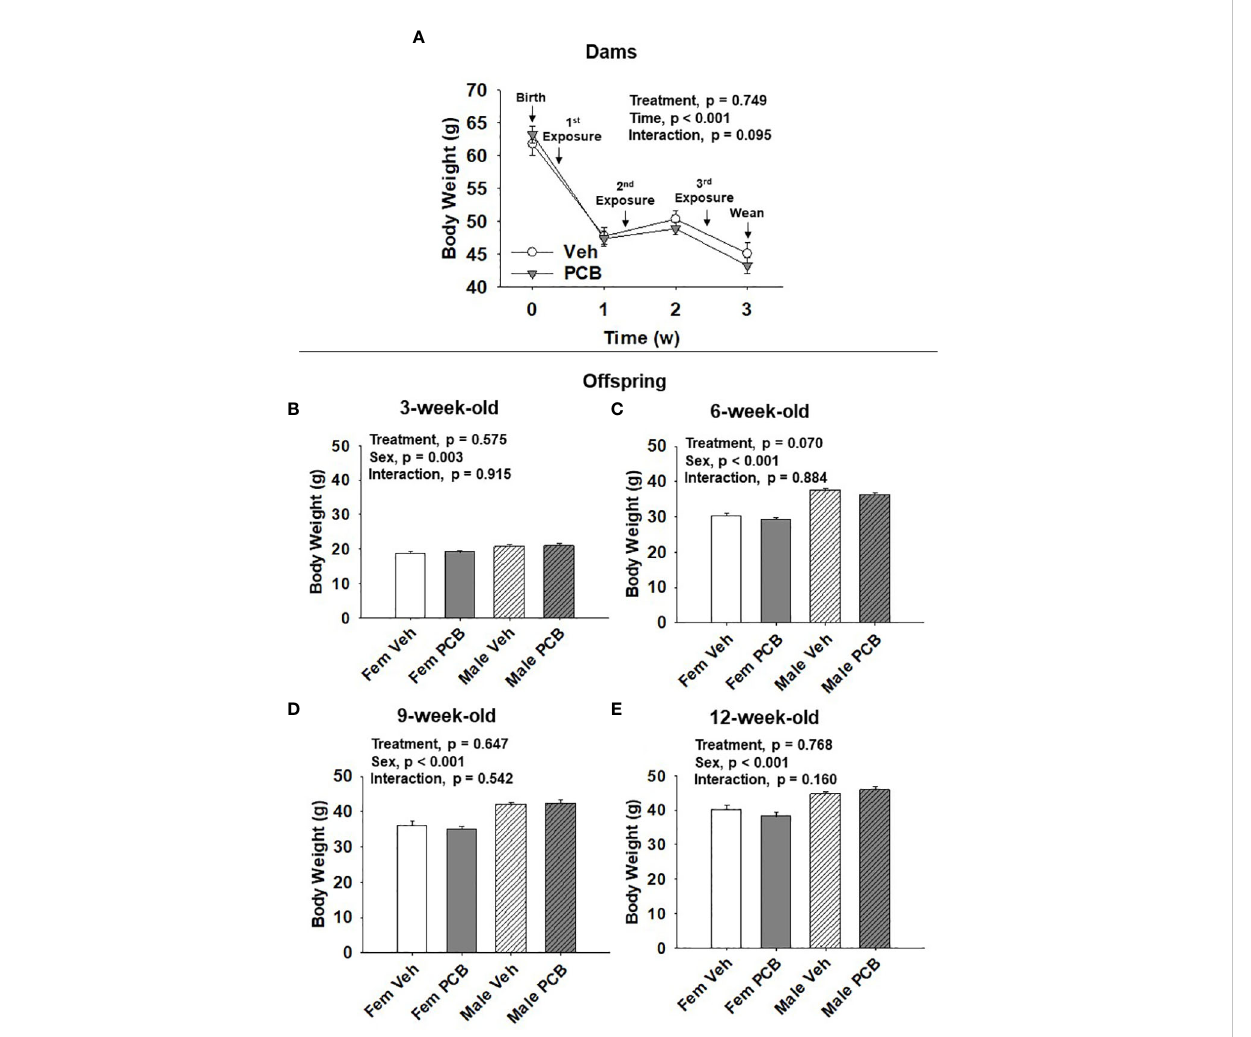
FIGURE 1 PCB126 exposure during the nursing period does not affect dam or offspring body weight. (A) The body weight of vehicle and PCB126-treated dams from parturition to weaning are shown. Dams received treatments respective to their experimental grouping 3, 10, and 17 days after delivery. Dam body weight values are representative of the mean ± SEM (n = 9 mice per group). The body weight of (B) 3-week-old (C) 6-week-old, (D) 9-week- old, and (E) 12-week-old offspring born to dams exposed to PCB126 or vehicle during the nursing period are shown. Offspring body weight values are provided as means of litter means ± SEM (n = 9 per group). Two-factor repeated measures ANOVA and two-factor ANOVA were respectively used to analyze dam and offspring body